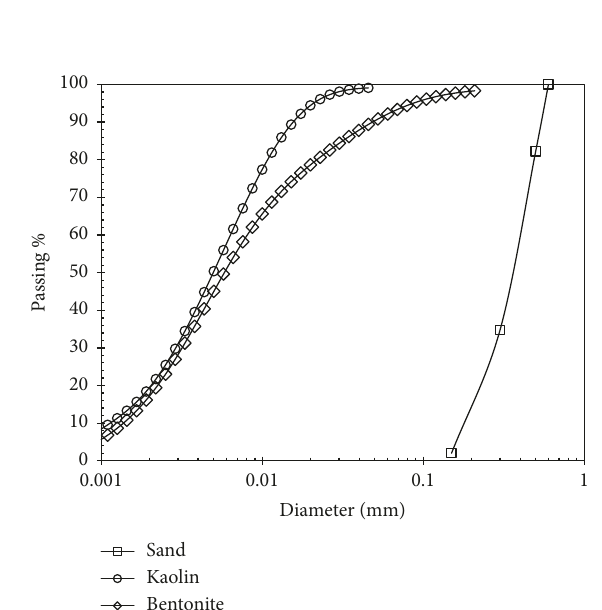
Figure 1: Particle-size distribution of tested